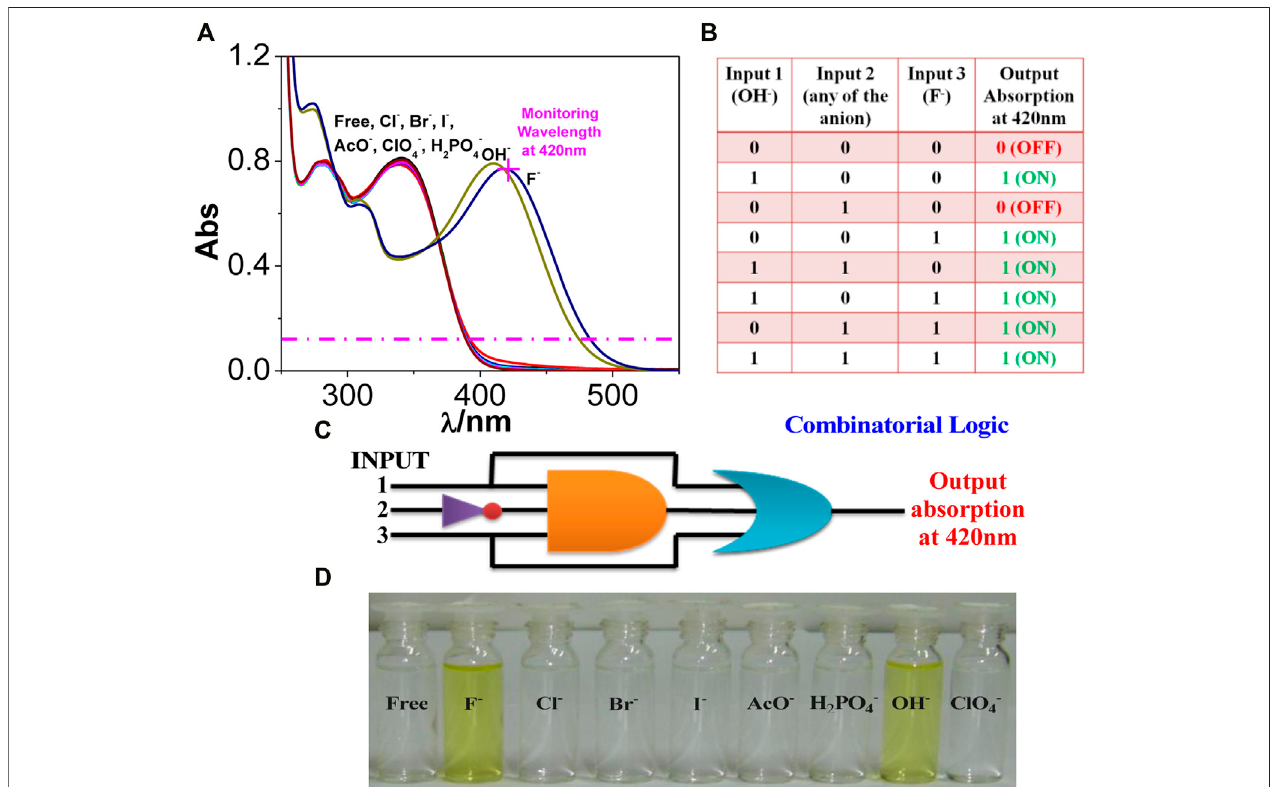
FIGURE 2 | (A) UV-Vis absorption spectrum of tpy-HImzPh 3 in the presence of different anions. (B) Truth table of the combinatorial logic system. (C) Schematic diagram of the combinatorial logic system. (D) Visual color changes in the presence of different anions.